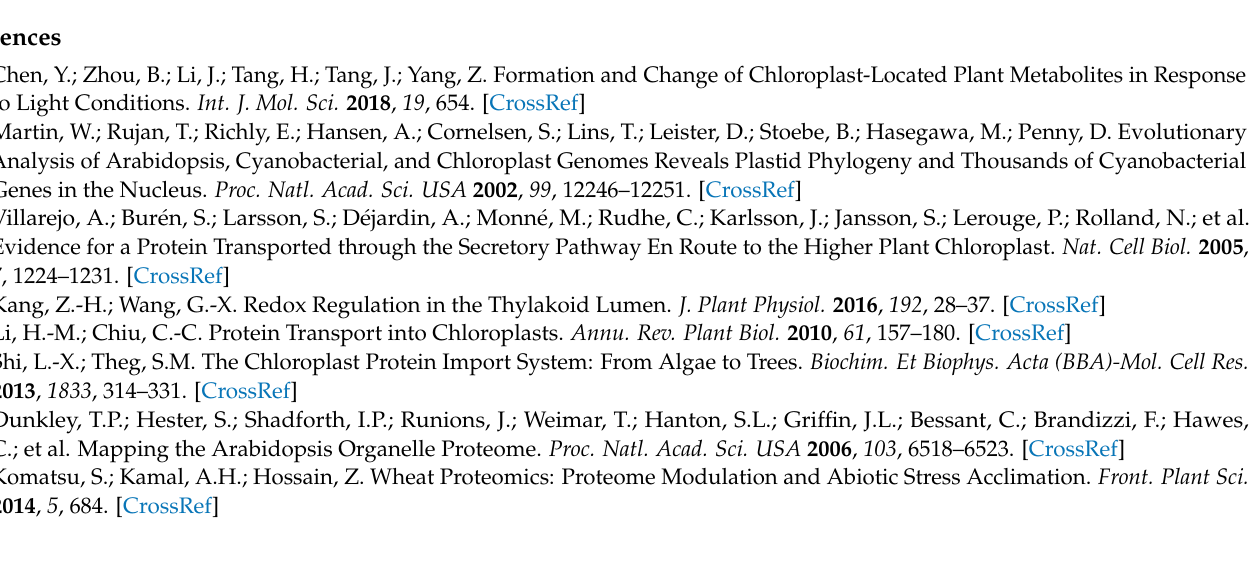
Table S6: The detailed information of KEGG pathway analyses for chloroplast-unique proteins set, Table S7: The protein accessions information for reconstructing the proposed pathways of starch metabolism in different